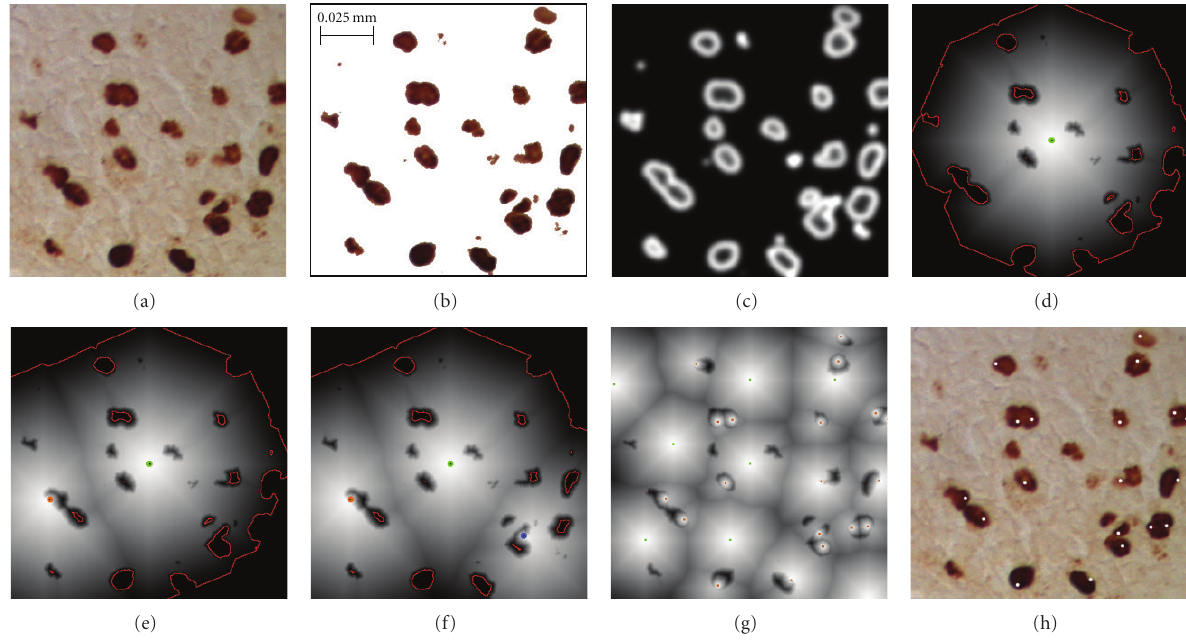
Figure 3: Step-by-step overview of ICS. (a) A slice sample using DAB staining under brightfield microscopy. (b) The original image after color filtering. (c) The di ff use edge detection bu ff er. (d) Expansion region after the first search iteration, with the initial seed placed at the center of the image (the green dot). The red outline in (d) (the border of the expansion region) illustrates the edges from where future seed points will be chosen. Figures (e) and (f) show the expansion regions after the second and third iterations, respectively. The new seed shown in (e) (the orange dot) was located on the red outline in (d), and the new seed shown in (f) (the blue dot) was located on the red outline in (e). (g) shows the result after all the expansions have taken place. (h) shows the positive cell location markers placed on the image once the algorithm ends; where two markers appeared in close proximity, the algorithm has detected two adjacent